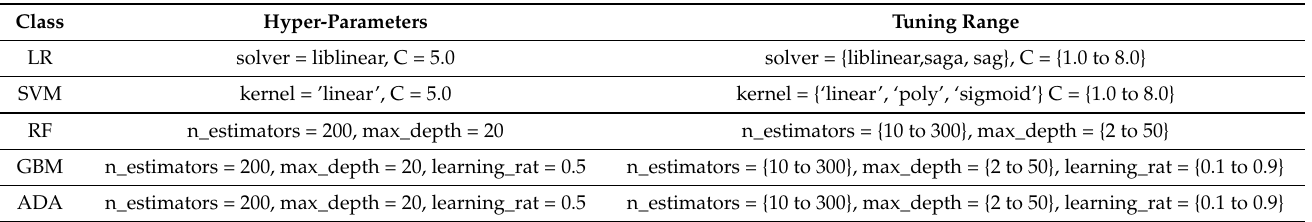
Table 7. Target class count for training and testing sets.